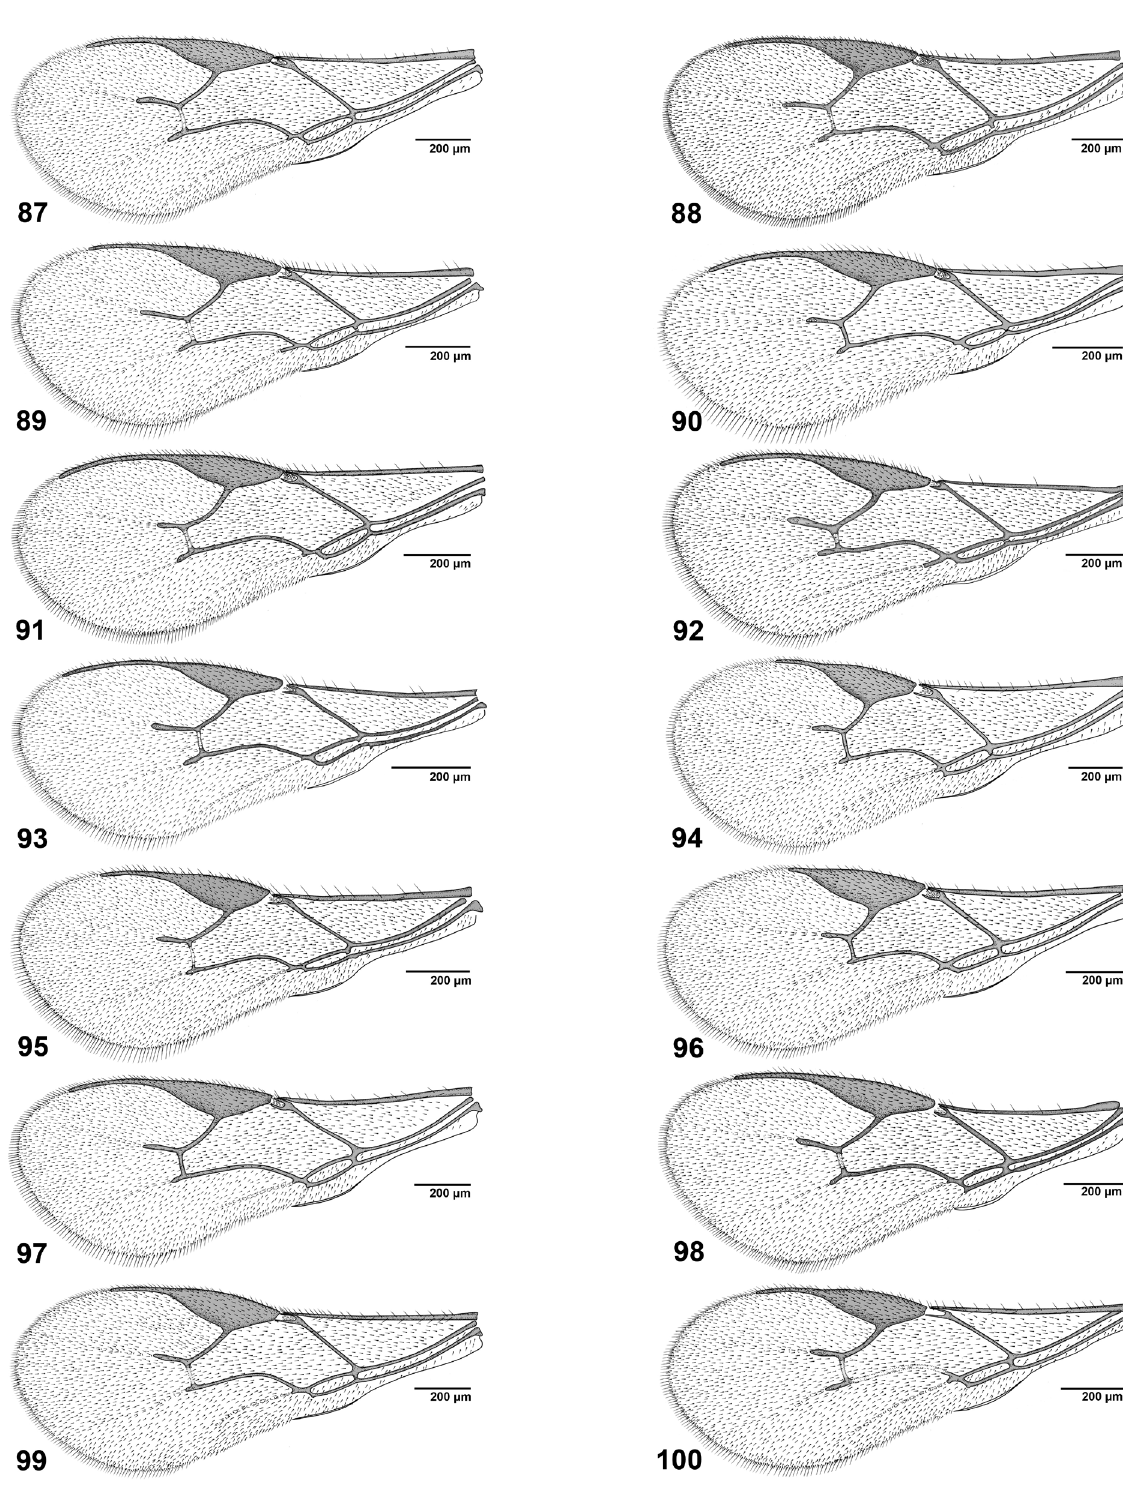
Figs 87–100. Forewing (♀): 87 . Aphidius ervi . 88 . Aphidius funebris . 89 . Aphidius hieraciorum . 90 . Aphidius iranicus . 91 . Aphidius matricariae . 92 . Aphidius microlophii . 93 . Aphidius myzocallidis . 94 . Aphidius persicus . 95 . Aphidius platensis . 96 . Aphidius popovi . 97 . Aphidius rhopalosiphi . 98 . Aphidius ribis . 99 . Aphidius rosae . 100 . Aphidius salicis